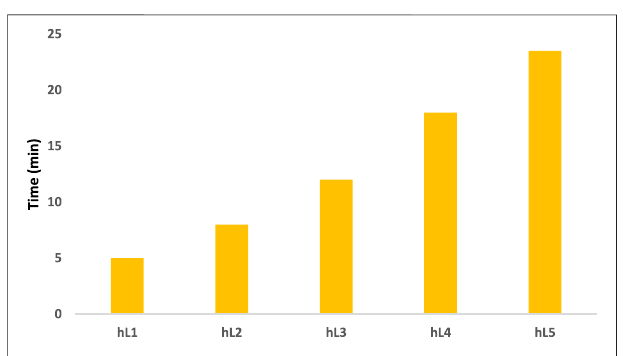
FIGURE 8 | Hidden layers-based performance validation using time consumption as a key